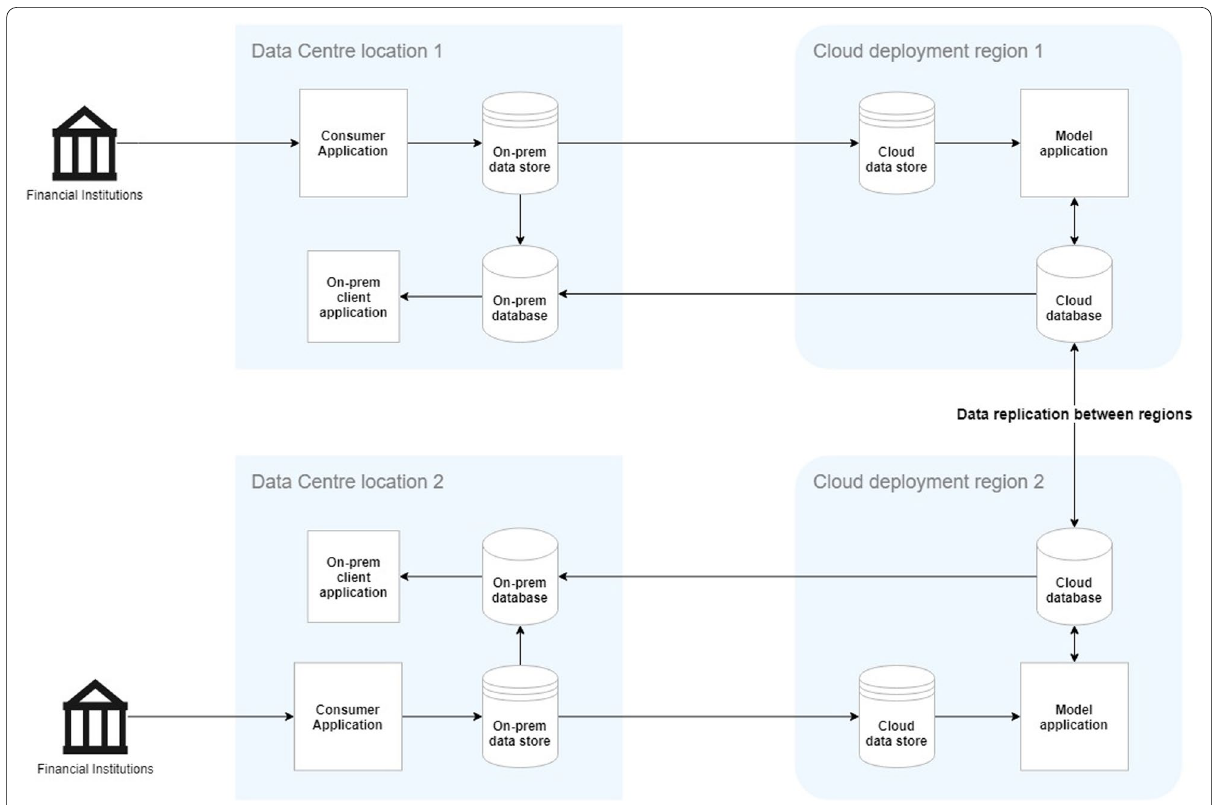
Fig. 1 Hybrid cloud deployment